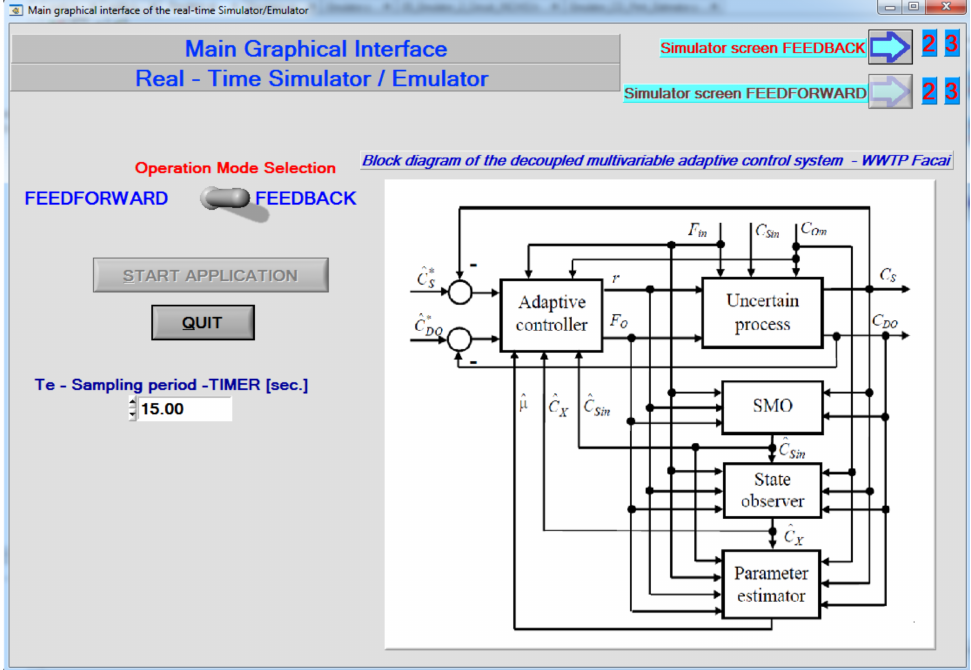
Figure 5. Main graphical interface of the software emulator of the controlled